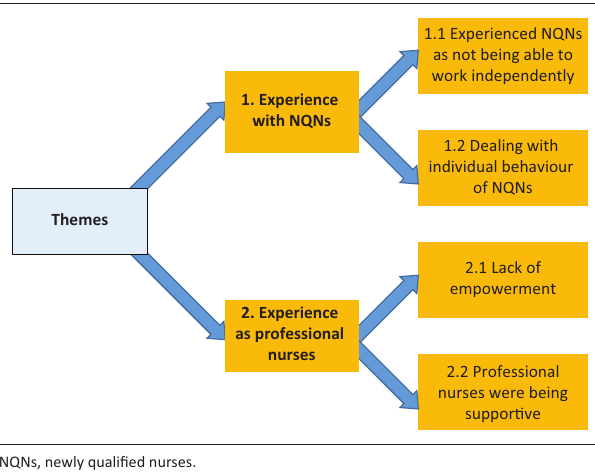
FIGURE 2: Themes and sub-themes for